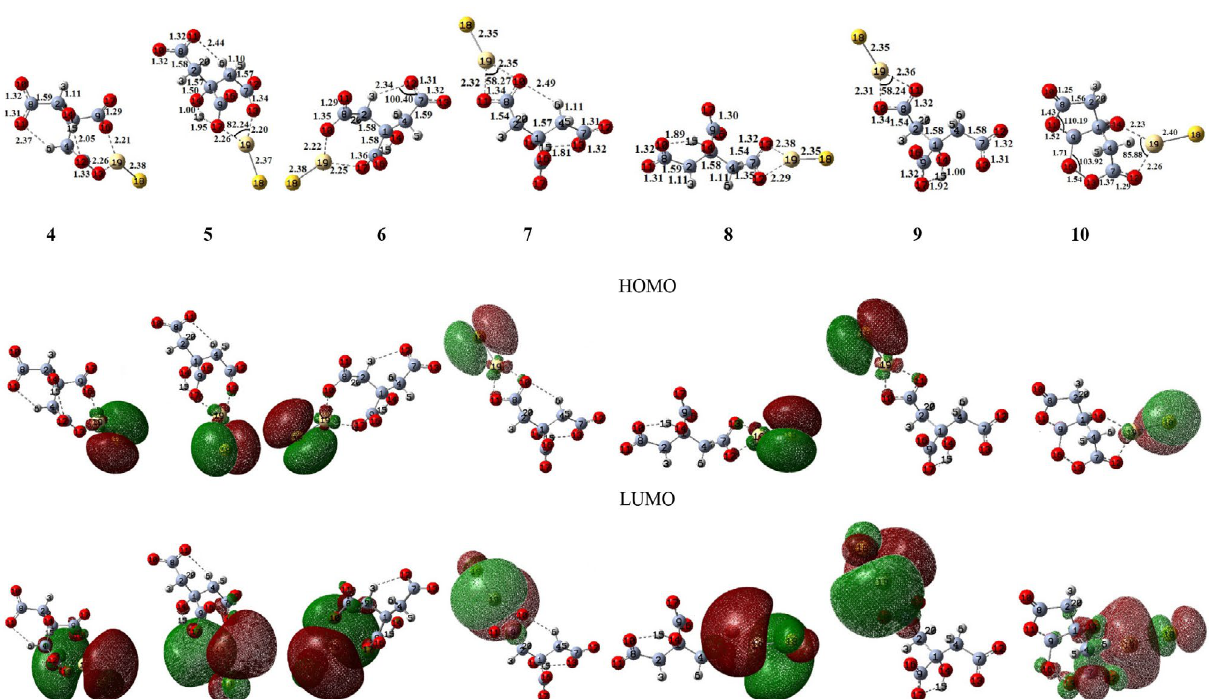
Figure 3. Selected geometrical parameters of the systems citrate ion-CdS whereby bond lengths are in angstroms (Å) and angles in °. HOMO and LUMO surfaces are depicted for all the